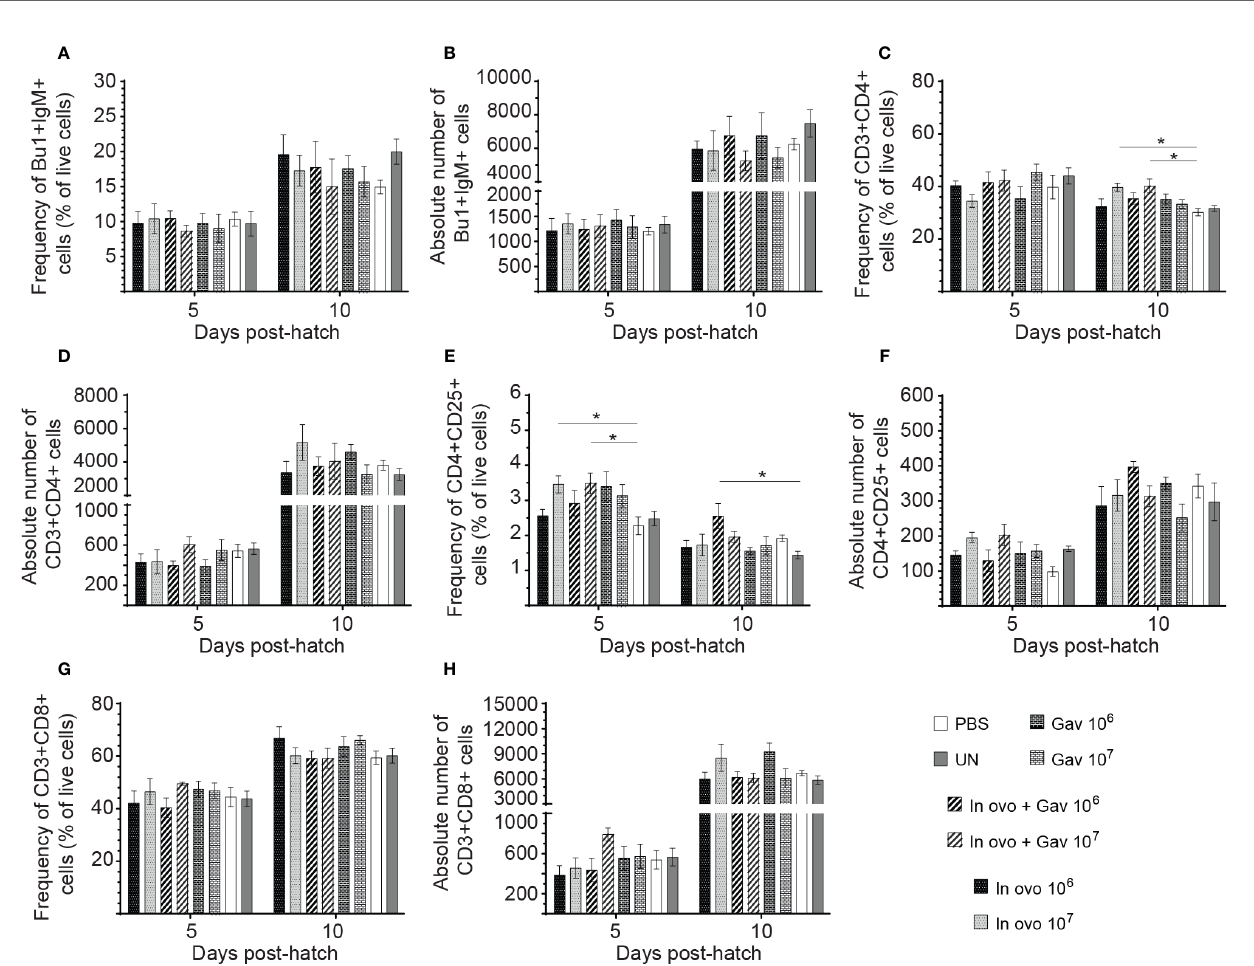
FIGURE 6 | Changes in the frequency of spleen lymphocytes cells mediated by lactobacilli inoculation. Spleen samples were collected at days 5 and 10 post-hatch from all treatment groups: groups 1 and 2 received 10 6 and 10 7 CFUs of lactobacilli cocktail in ovo , respectively, at embryonic day eighteen; groups 3 and 4 received 10 6 and 10 7 CFUs of lactobacilli, respectively, via both in ovo and oral gavage (on days 1, 7, 14, 21, 28 post-hatch); groups 5 and 6 received 10 6 and 10 7 CFUs of lactobacilli, respectively, via oral gavage; group 7 was served as a negative control group and was injected with phosphate-buffered saline (PBS); group 8 remained untreated (UN). Spleen mononuclear cells were stained and fl ow cytometric analysis was performed to determine the respective frequency and absolute numbers of B cells (Bu-1 + IgM + ; A, B ) and (C) T cell subsets (CD3 + CD4 + , CD3 + CD4 + CD25 + , CD3 + CD8 + ; C – H ). Statistical signi fi cance among treatment groups was calculated using SAS Proc GLM (General Linear Model) followed by Tukey ’ s comparison test. Error bars represent standard errors of the mean. Results were considered statistically signi fi cant if P < 0.05. Bars with asterisks represent a signi fi cant difference among treatments. The data are representative samples from 6 individual